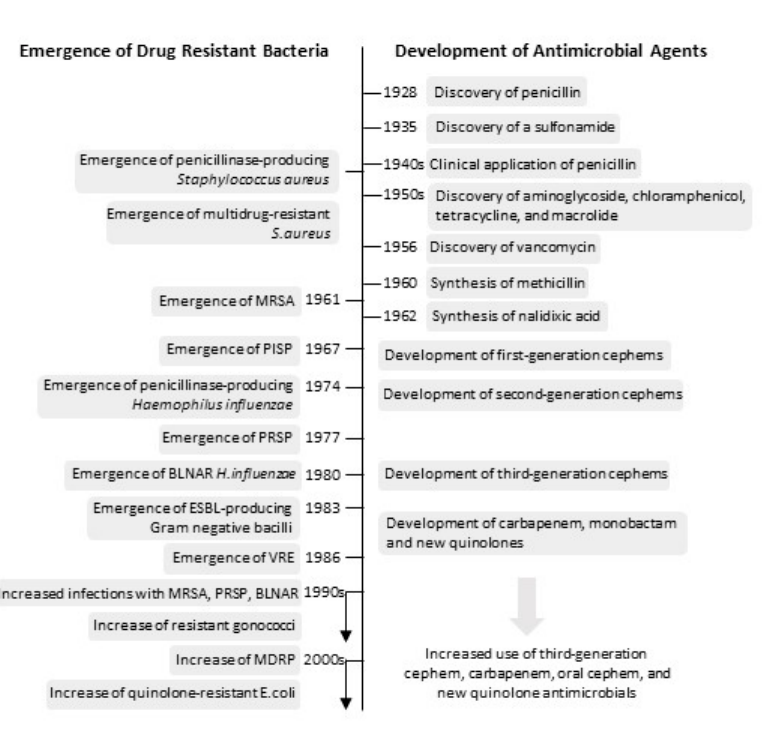
Figure 2. Trend of development of antimicrobial agents and emergence of drug-resistant bacteria [46]. MRSA, Methicillin-resistant Staphylococcus aureus; PISP, penicillin-intermediate-resistant S. pneumoniae; PRSP, penicillin-resistant S. pneumoniae; VRE, vancomycin-resistant enterococci; BLNAR, β -lactamase-negative ampicillin-resistant; MDRP, Multidrug-Resistant Pseudomonas Aeruginosa. Figure adapted from [46].